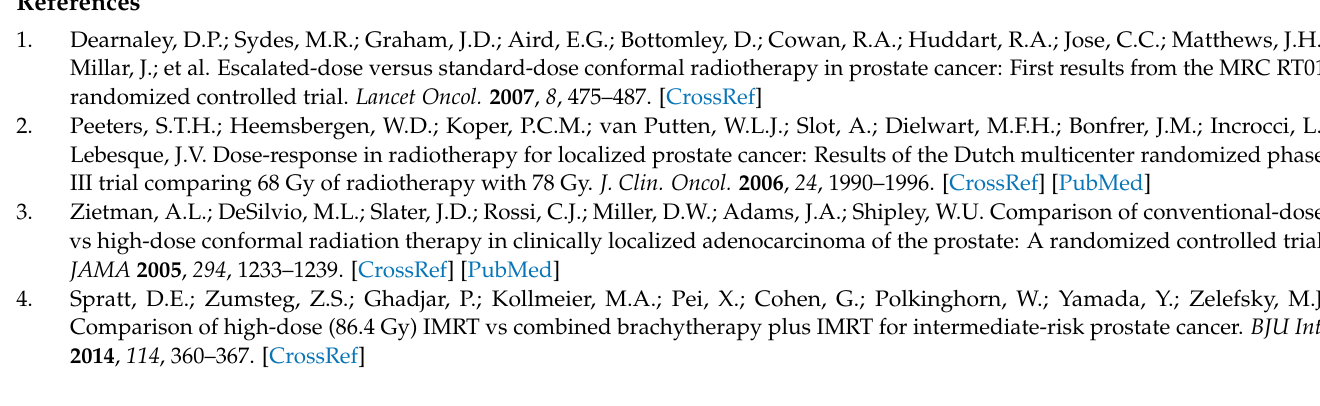
of DMFS between EBRT and BT-boost in VHR-1 group. ( b ) Comparison of DMFS between EBRT and BT-boost in VHR-0 group. ( c ) Comparison of DMFS between EBRT and BT-boost in intermediate-risk group. Figure S2: Prostate cancer specific survival rate (PCS), ( a ) Comparison of PCS between EBRT and BT-boost in VHR-1 group. ( b ) Comparison of PCS between EBRT and BT-boost in VHR-0 group. ( c ) Comparison of PCS between EBRT and BT-boost in intermediate-risk group. Figure S3: Overall survival rate (OS), ( a ) Comparison of bDFS between EBRT and BT-boost in VHR-1 group. ( b ) Comparison of bDFS between EBRT and BT-boost in VHR-0 group. ( c ) Comparison of bDFS between EBRT and BT-boost in intermediate-risk group. Table S1: Detailed treatment schedule, Table S2: Comparison of background of Patient characteristics after propensity score matching, Table S3: Background Comparison between BT-boost and DeRT after propensity score